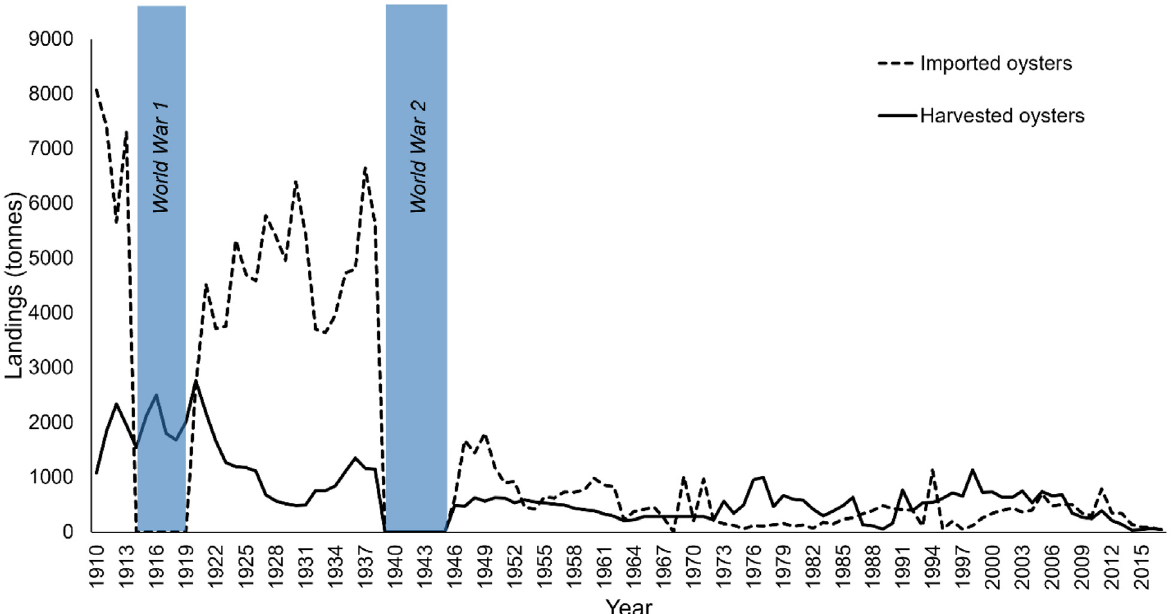
Fig. 2. Oyster landings for England and Wales from 1910 to 2017; black line denotes landings harvested within UK waters and dashed black line denotes landings of imported oysters. Note, blue regions when landings were not recorded reliably during WWI (1914 – 1918) and WWII (1939 –